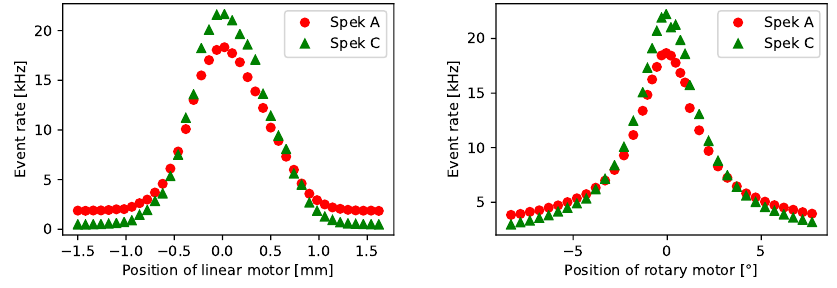
Figure 5. Spectrometer rates in relation to the target position. Left: the linear position of the target parallel to the beam was changed. Right: the rotary position was changed. In both cases, 855MeV electrons with 3 µ A beam current were